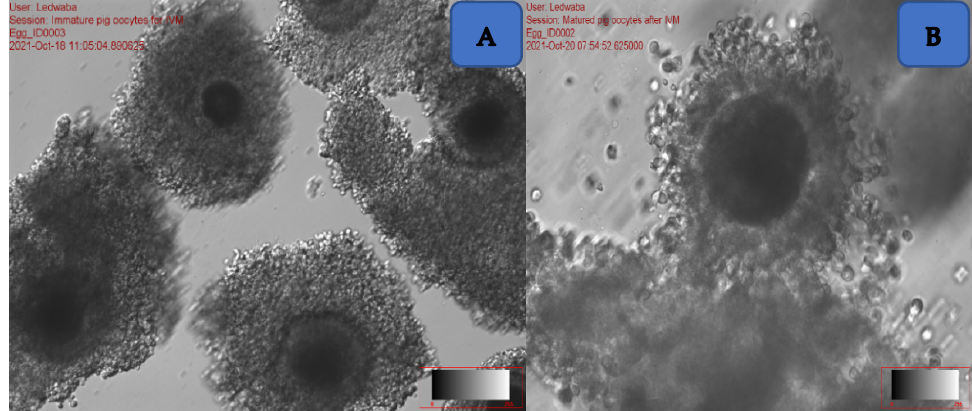
Figure 1. ( A ) Immature oocytes at 40X magnification; ( B ) mature oocyte at 60×